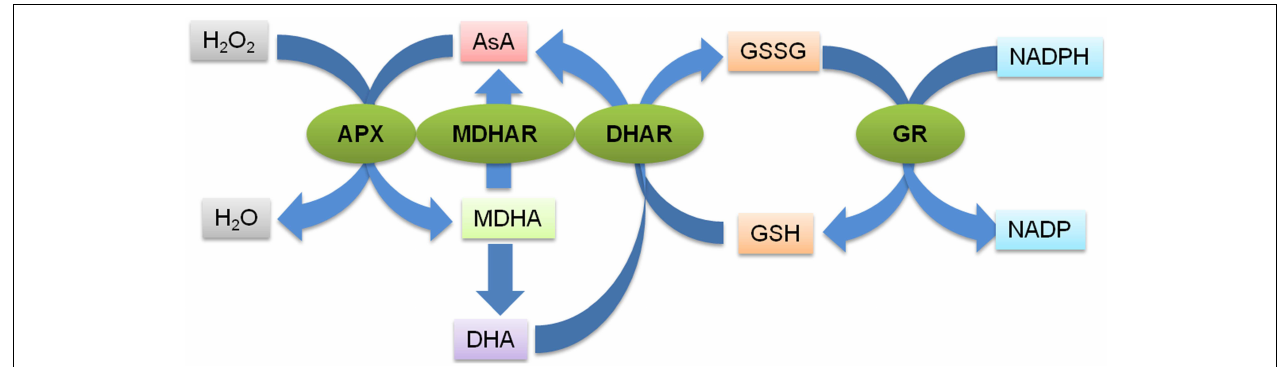
FIGURE 1 | Schematic representation of the AsA-GSH pathway. The first step of the pathway is the detoxification of H 2 O 2 by APX catalyzed peroxidation of AsA which generates MDHA. MDHA is either reduced back to AsA by MDHAR or it undergoes non-enzymatic disproportionation to AsA and dehydroascorbate (DHA). The DHA molecules are reduced to AsA by DHAR using GSH as the reductant. GSH is regenerated from the oxidized glutathione dimers (GSSG) by